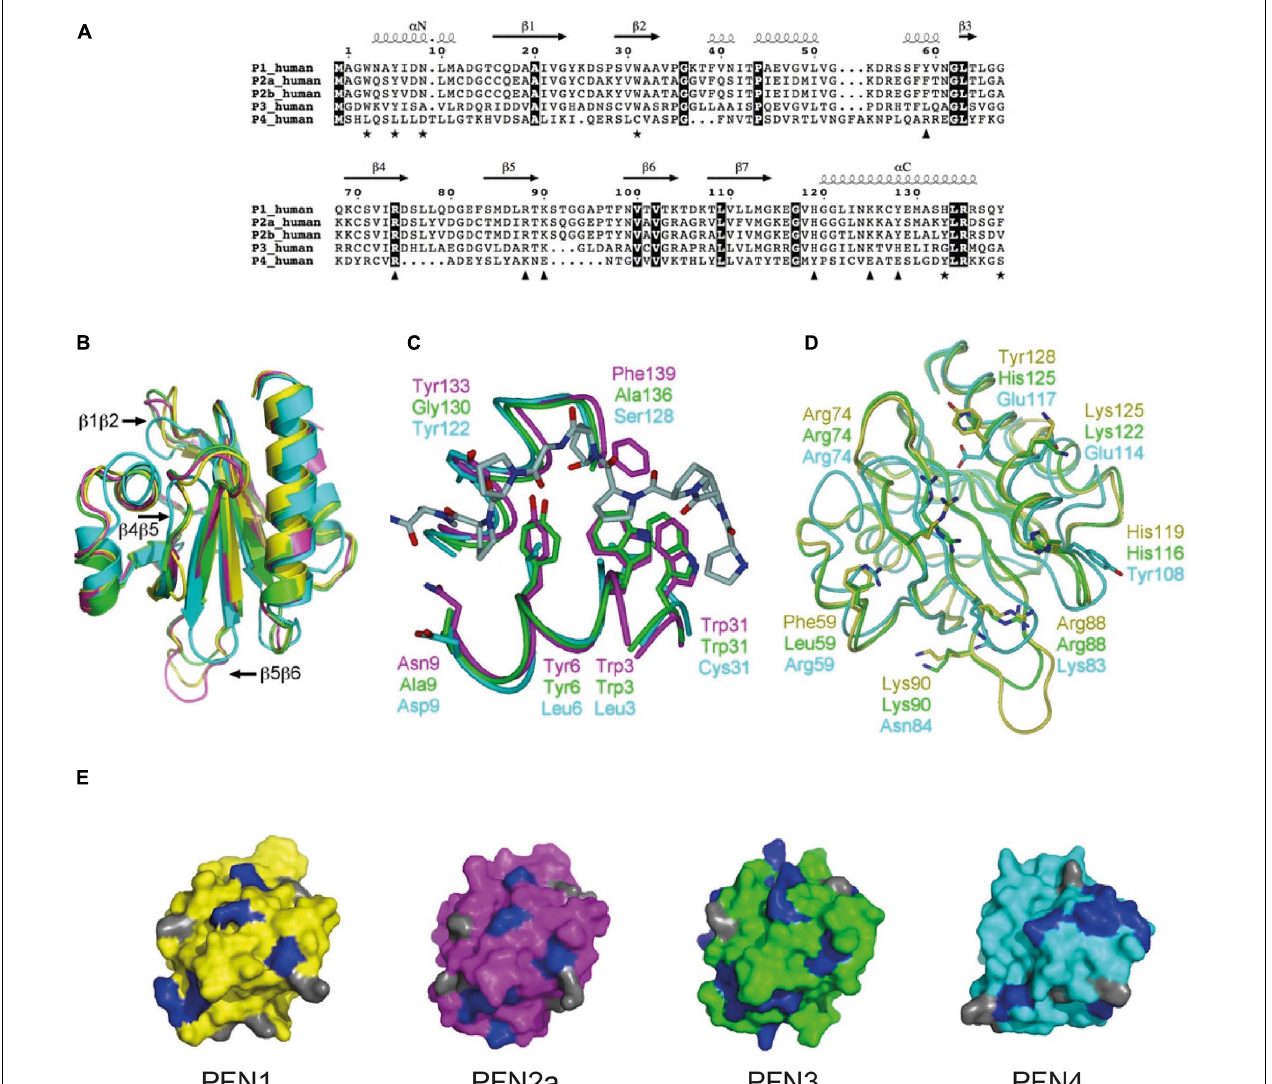
FIGURE 3 | Structural features reflect the different biochemical properties of the mammalian profilin isoforms. (A) Sequence alignment between human profilins. Fully conserved residues are on dark background. Key residues of PLP binding are indicated by asterisks, those involved in binding actin with triangles. Secondary structures are derived from bovine PFN1 crystal structure. For compatibility with most publications, the first methionine is not considered in sequence numbering. (B) Superposition of bovine PFN1 (yellow), mouse PFN2a (magenta), human PFN3 (green), and human PFN4 (cyan). PFN1 structure is from the profilactin complex (PDB core 1HLU) and PFN2a from the complex with a VASP peptide (PDB code 2V8C). Loops variable in length in PFN3 and/or PFN4 are marked. (C) Comparison of the PLP-binding sites of PFN2a, PFN3, and PFN4. Shown is also the PFN2a-VASP complex, coloring as in 3B. Only half of the binding site is conserved in PFN3, no conservation is seen in PFN4. Key residues for peptide binding are indicated. (D) Actin-binding sites of PFN1, PFN3, and PFN4, coloring as in 3B. For clarity, actin is not shown; view is from the direction of actin onto the actin-binding surface on profilin, side chains of key profilin residues are shown. (E) Comparison of PtdIns(4,5)P2 binding surfaces of PFN1, 2a, 3, and 4 (left to right, respectively). Profilins are colored as in 3A, and all arginine residues, crucial for PtdIns(4,5)P2 binding, are highlighted in blue; lysine residues are shown in gray. This figure is used in this review with permission from Behnen et al.